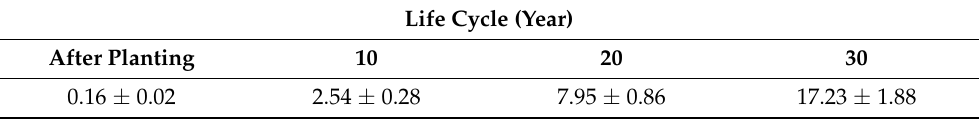
Table 8. Changes in cumulative carbon uptake per unit area over the life cycle of study parks (kg/m 2